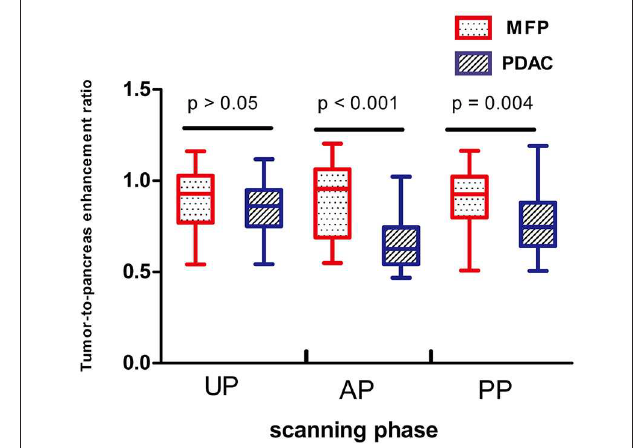
FIGURE 6 | Box-and-whisker plots of enhancement ratios of patients with MFP and PDAC in unenhanced, arterial, and portal phases. Enhancement